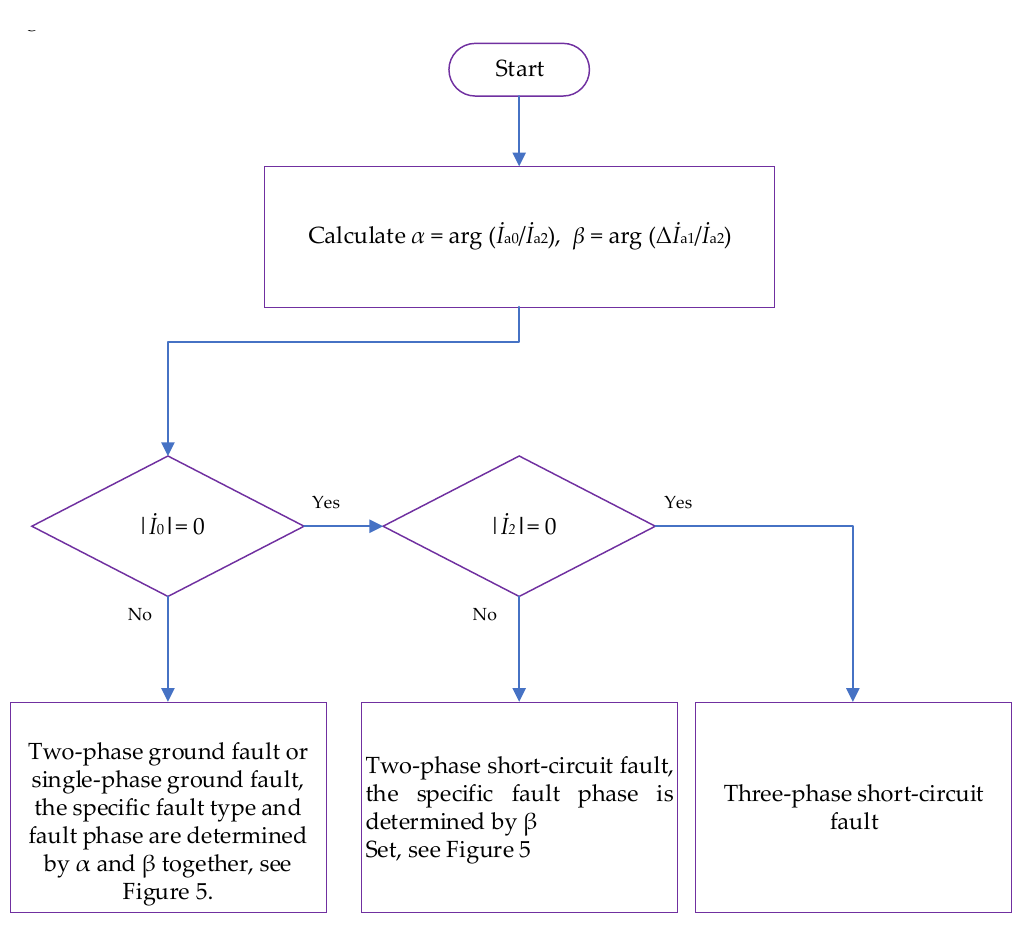
Figure 4. The proposed current sequence-based phase-selector mechanism. Electronics 2018 , 7 , x FOR PEER REVIEW